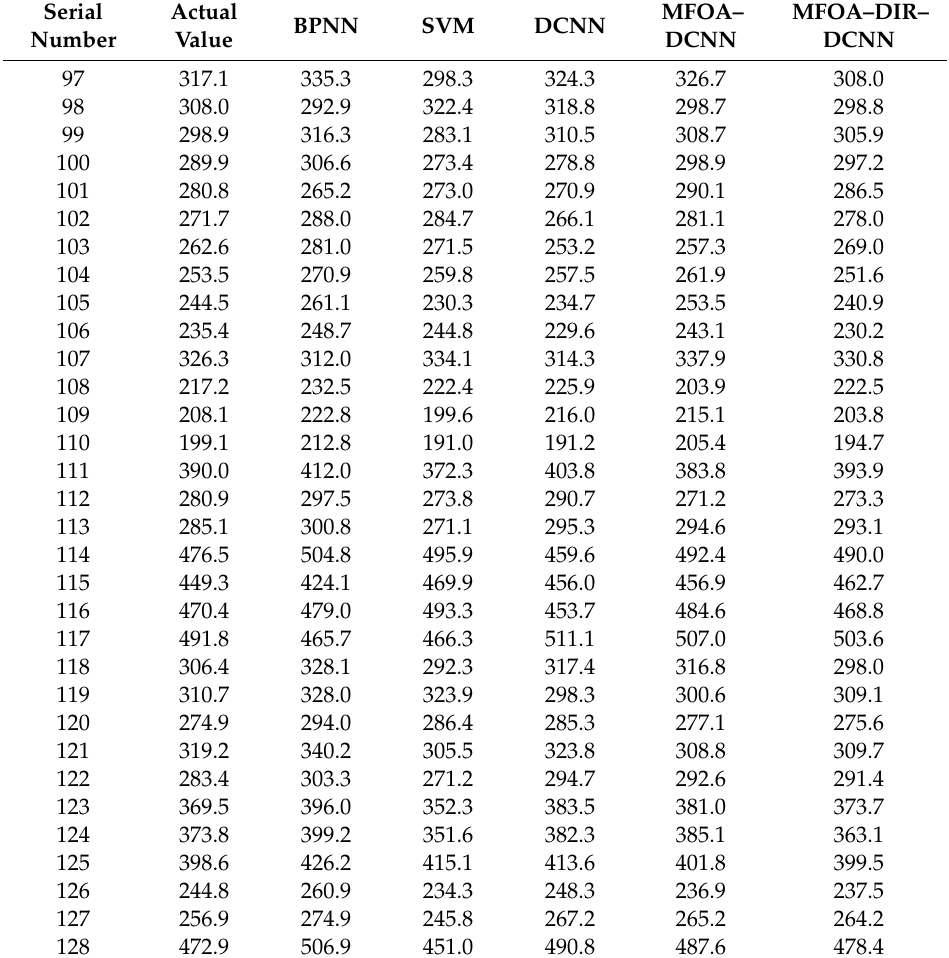
Table 2. Actual and predicted values of the testing sample (Unit: CNY / kV ·